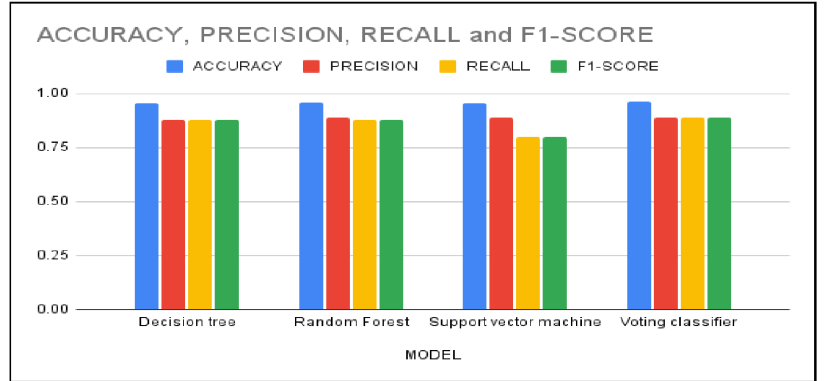
Figure 9. Comparison and results of the models.